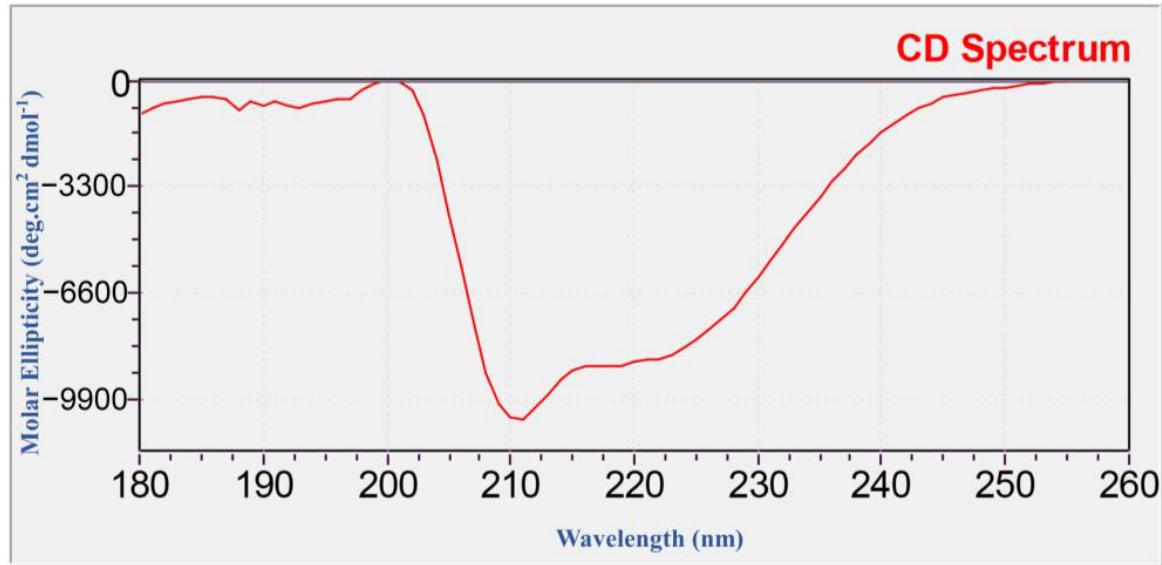
Figure 3. UV (180 – 260 nm) scan of SnocOBP9. The abscissa represents the scanning wavelength, and Figure 3. UV (180–260 nm) scan of SnocOBP9. The abscissa represents the scanning wavelength, and the ordinate represents the m olar ellipticity [θ] (deg.cm 2 dmol − 1 ). the ordinate represents the molar ellipticity [ θ ] (deg · cm 2 dmol − 1